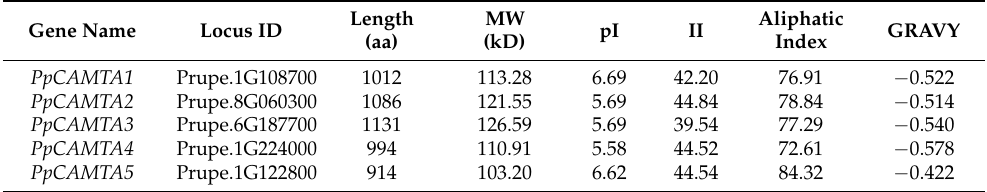
Table 1. Physicochemical properties of peach CAMTA proteins.